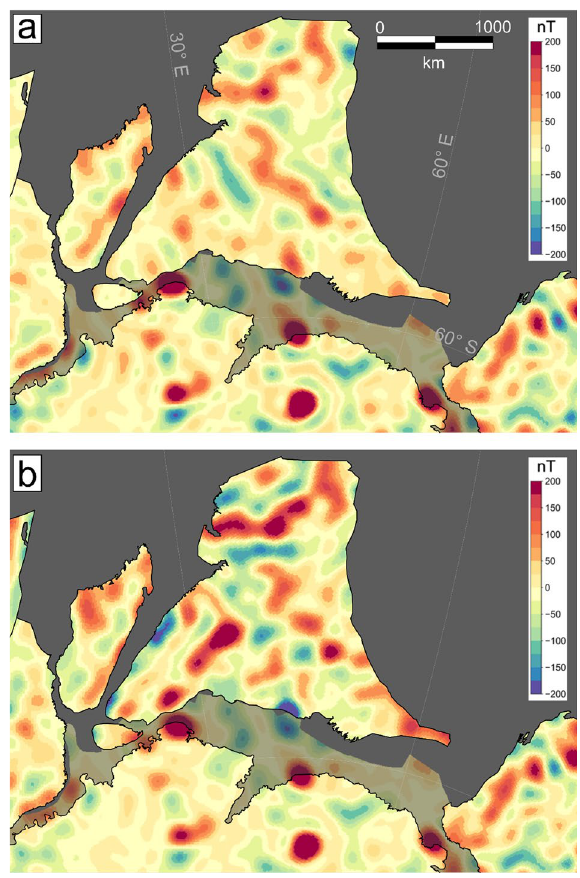
Figure 5. Zoom in on the India-Antarctica connection. ( a ) Original satellite mode LCS-1, ( b ) RTP corrected satellite model. Both data sets are represented at 5 km height. All data sets are rotated back to 200 Ma. Semi- transparent anomalies indicate aeromagnetic anomalies on the continental